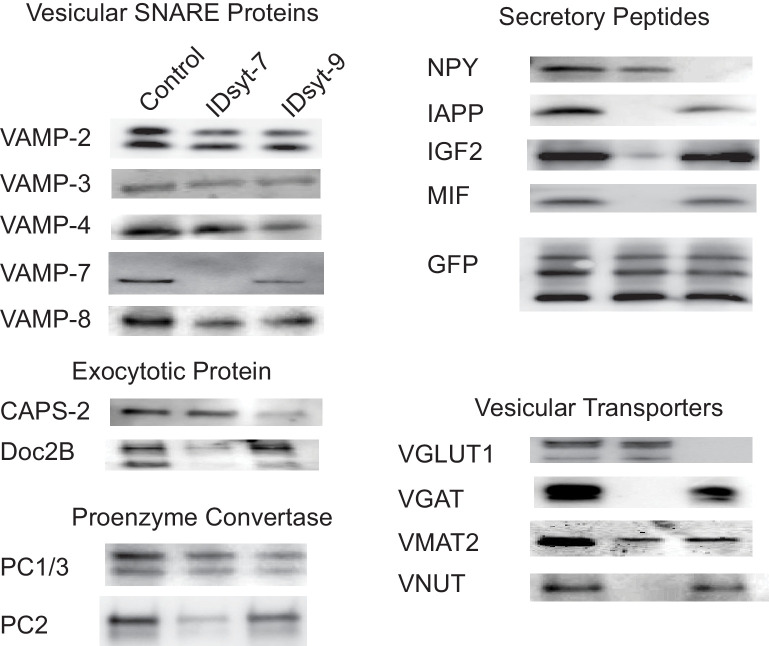
Western blots for proteins associated with GRINCH cell-derived insulin granules before immunodepletion (left lanes) and after immundepletion of intact granules using antibodies against syt7 (middle lanes) or syt9 (right lanes).Samples were divided into three equal parts: control (unaltered) and each of the other two immunodepleted. All three were solubilized in SDS-loading buffer and western blotting was performed on an equal fraction of the total of each sample. The three bands in the GFP blot are from top to bottom: proinsulin-GFP, conversion intermediate, C-peptide-GFP. The results shown were reproduced in three completely independent experiments.